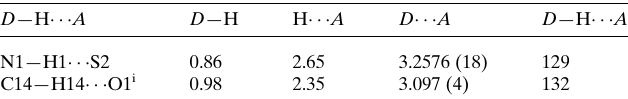
Table 1 Hydrogen-bond geometry (A˚ , (cid:2) ).